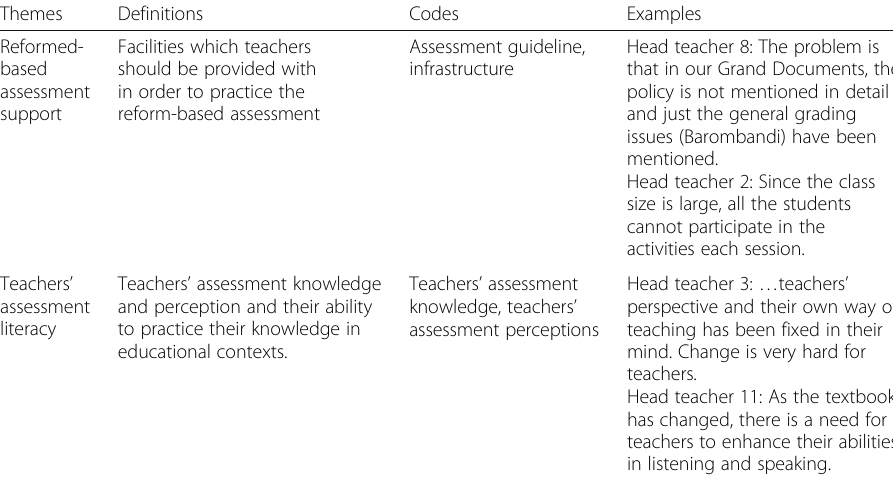
Table 1 Themes, definitions, codes, and